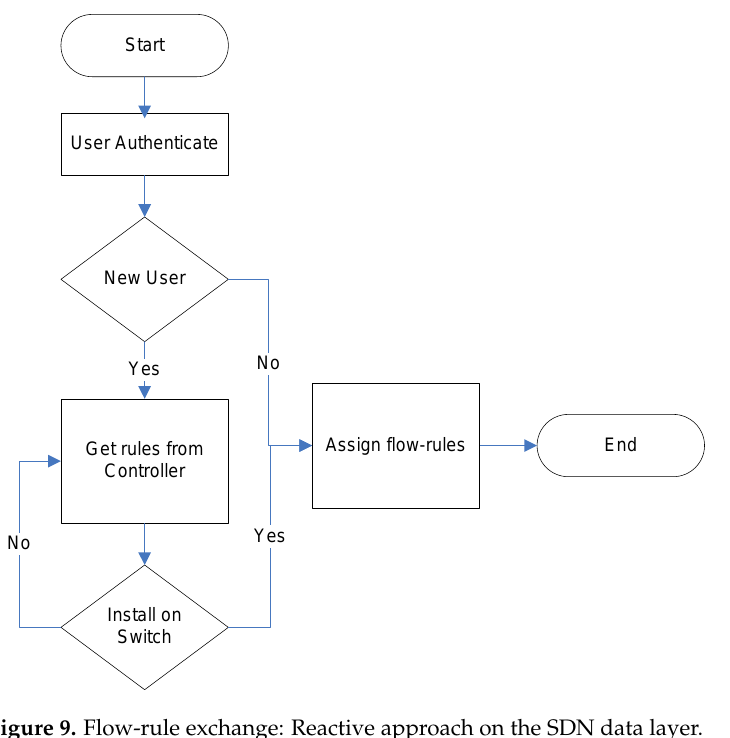
Figure 9. Flow-rule exchange: Reactive approach on the SDN data layer.